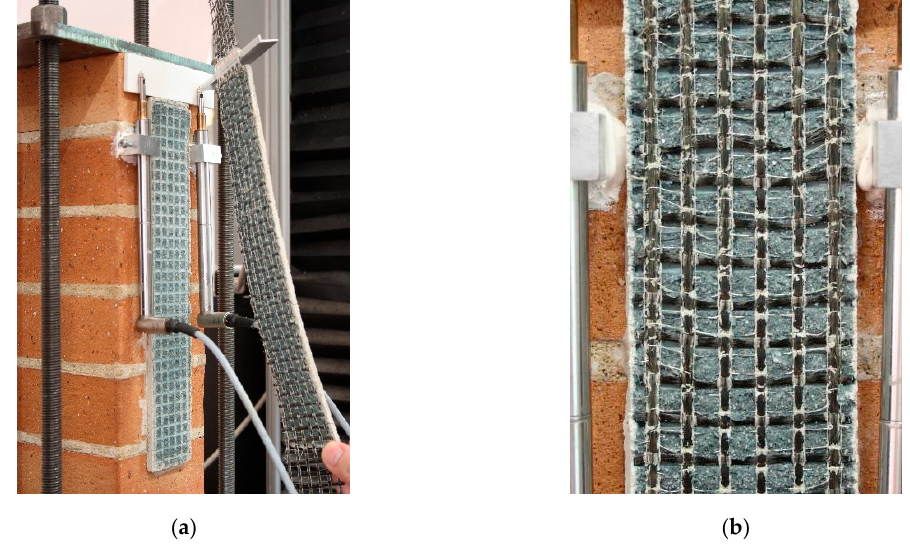
Figure 16. ( a ) Failure mode (C), ( b ) detail of textile rupture in the failure mode (C/E).